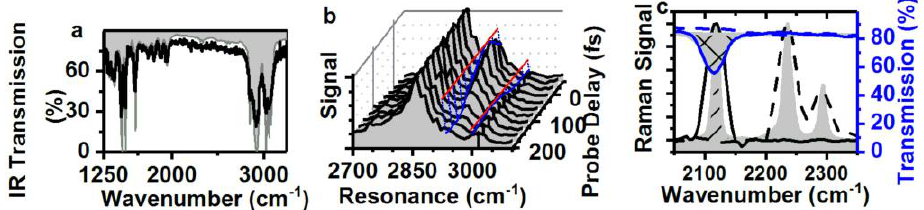
Fig. 2 . (a) Polystyrene IR transmission measured in single beam SF setup (solid line) and FTIR- reference measurement (grey background). (b) The time resolved CARS coherences of the CH resonances in sunflower oil indicates a build up at 3015 cm -1 and a decay at 2940 cm -1 relative to 2850 cm -1 . (c) Raman signals (black lines) and IR transmissions (blue lines) for 1-Octyne (solid line) and 4-Octyne (dotted line). The corresponding references are given as the grey background for 1- Octyne Raman (single stripes), 4-Octyne Raman (without stripes) and 1-Octyne IR transmission (crossed